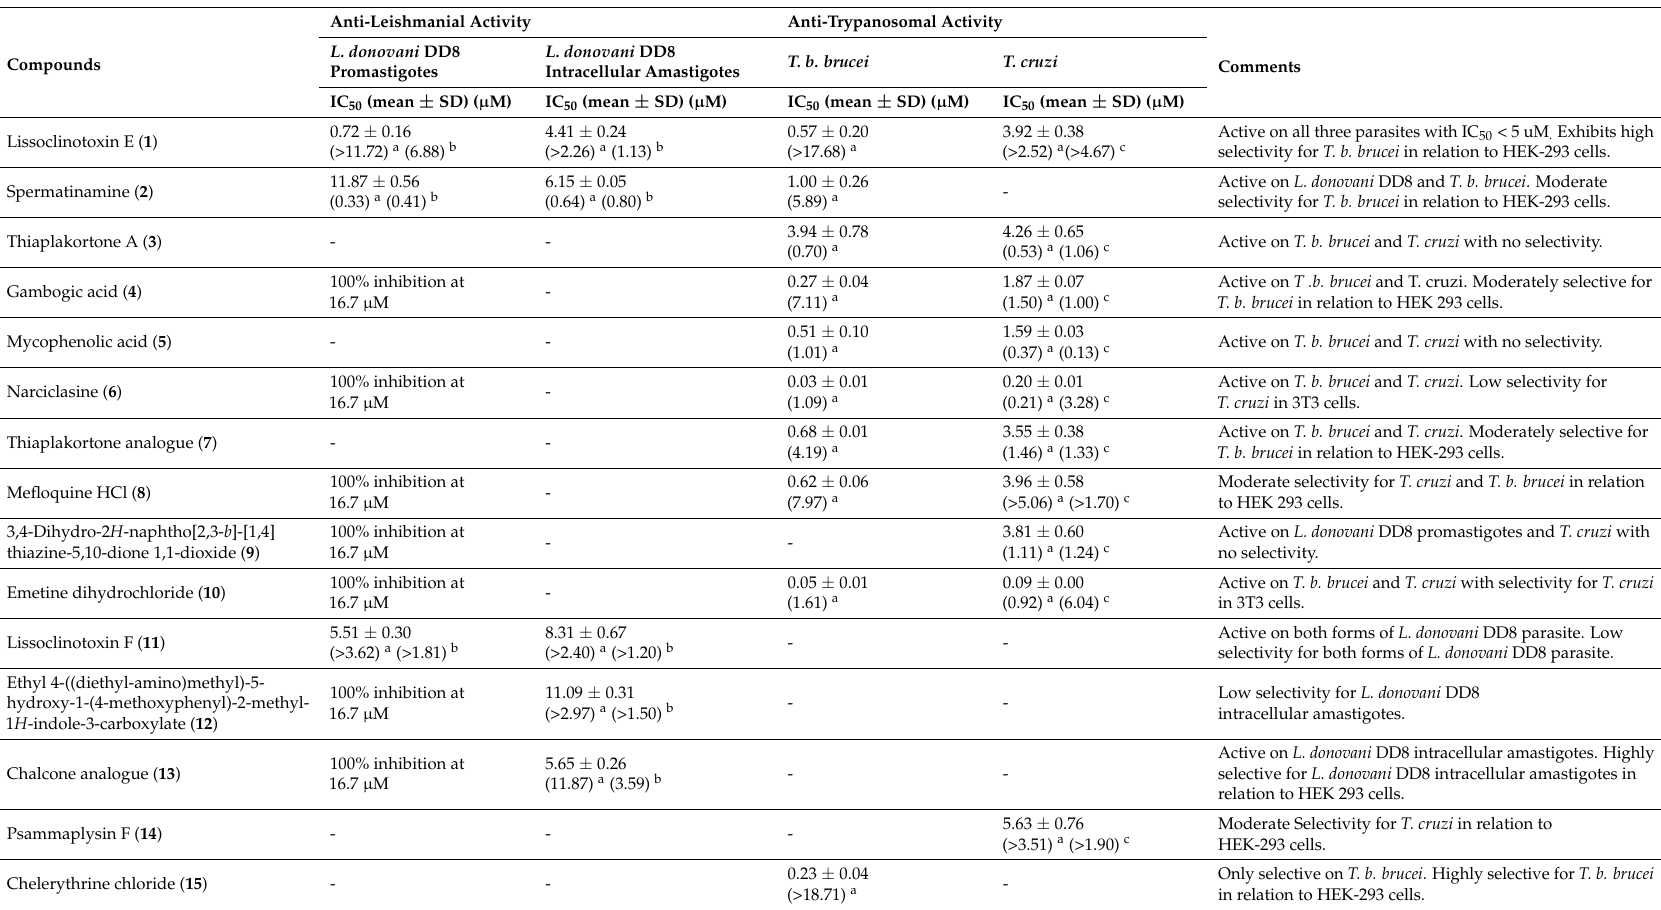
Table 2. In vitro anti-kinetoplastid activities of